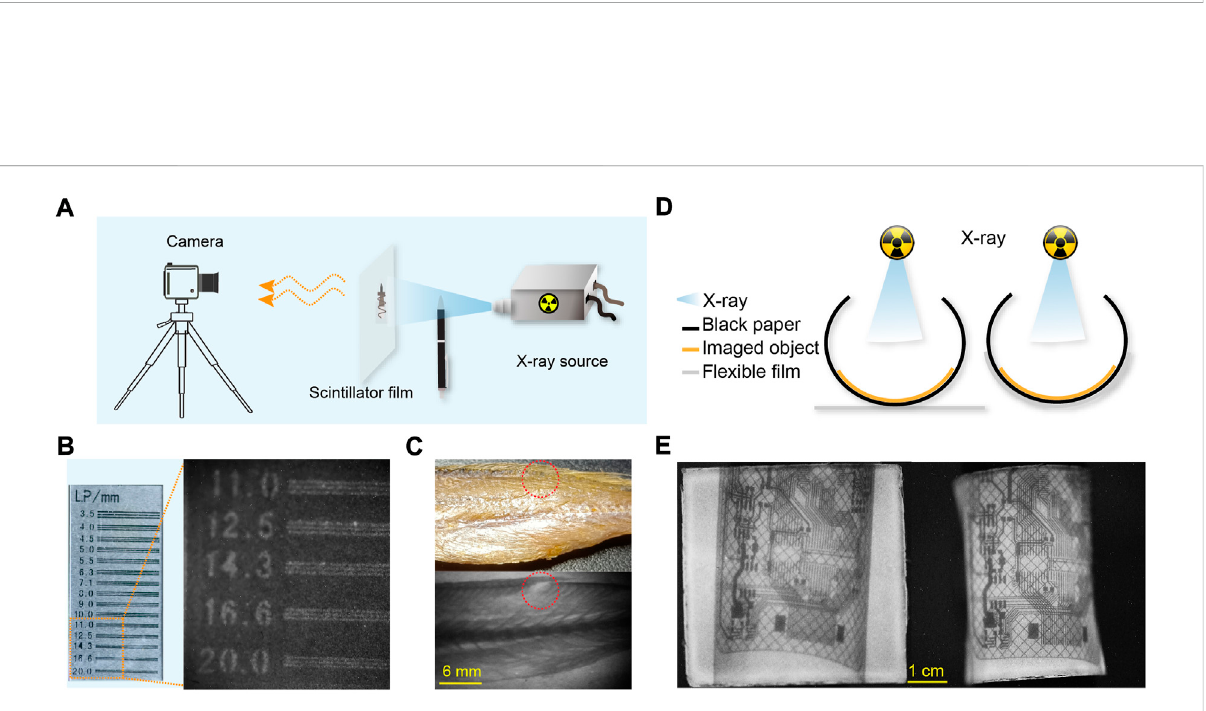
FIGURE 4 High-resolution, fl exible X-ray luminescence imaging. (A) Schematicdiagramofahome-madeimaging system. (B) Bright- fi eldimage(left)and X-ray imaging (right) of a standard line pair card. (C) Bright- fi eld (top) and X-ray imaging (bottom) of a small yellow croaker; the red dotted circle representsthesameposition. (D) Schematicdiagramofdifferentimagingmodes,includingX-rayimaging fi lmattachedtothetargetobjectorplaced outside the target object. (E) Plane imaging (left) and curved, fl exible imaging (right) of a bend circuit board.